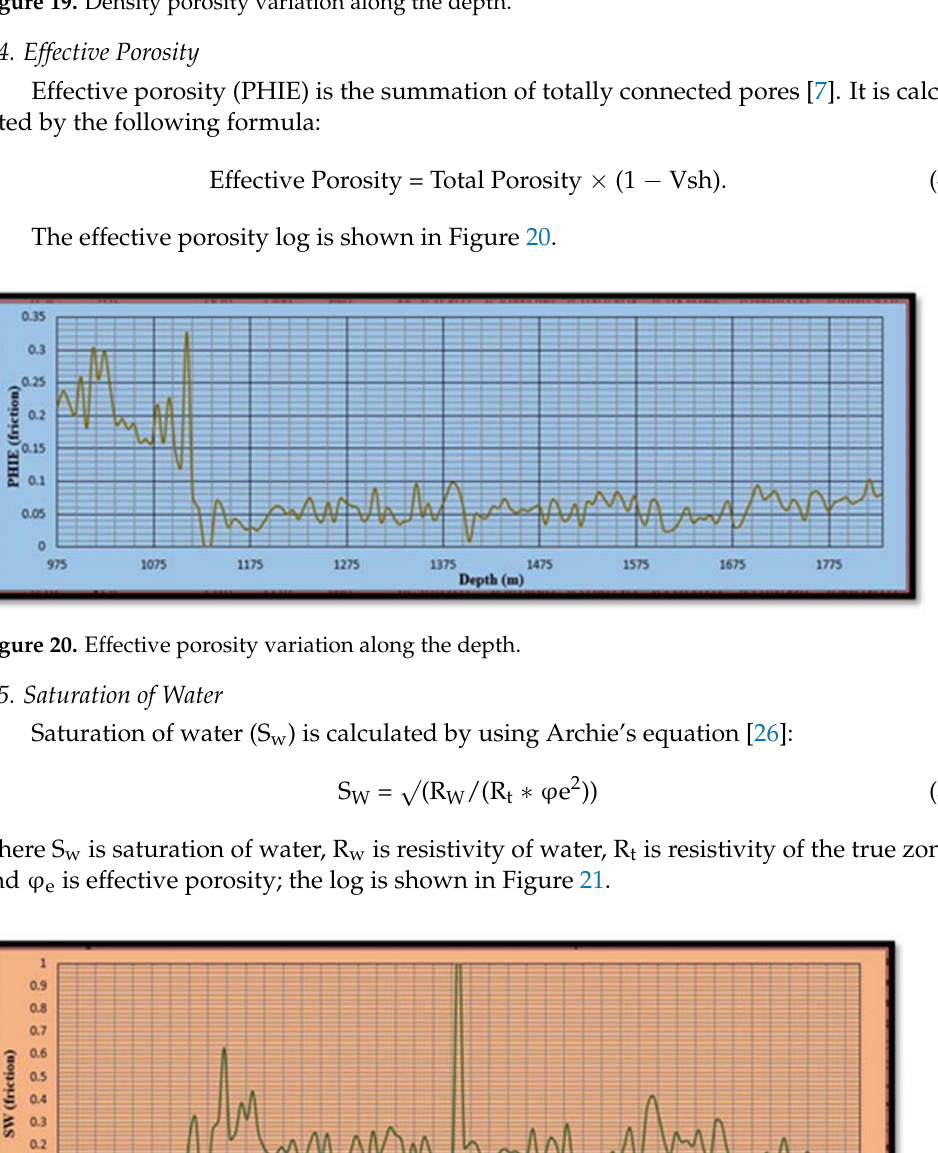
Figure 19. Density porosity variation along the depth.